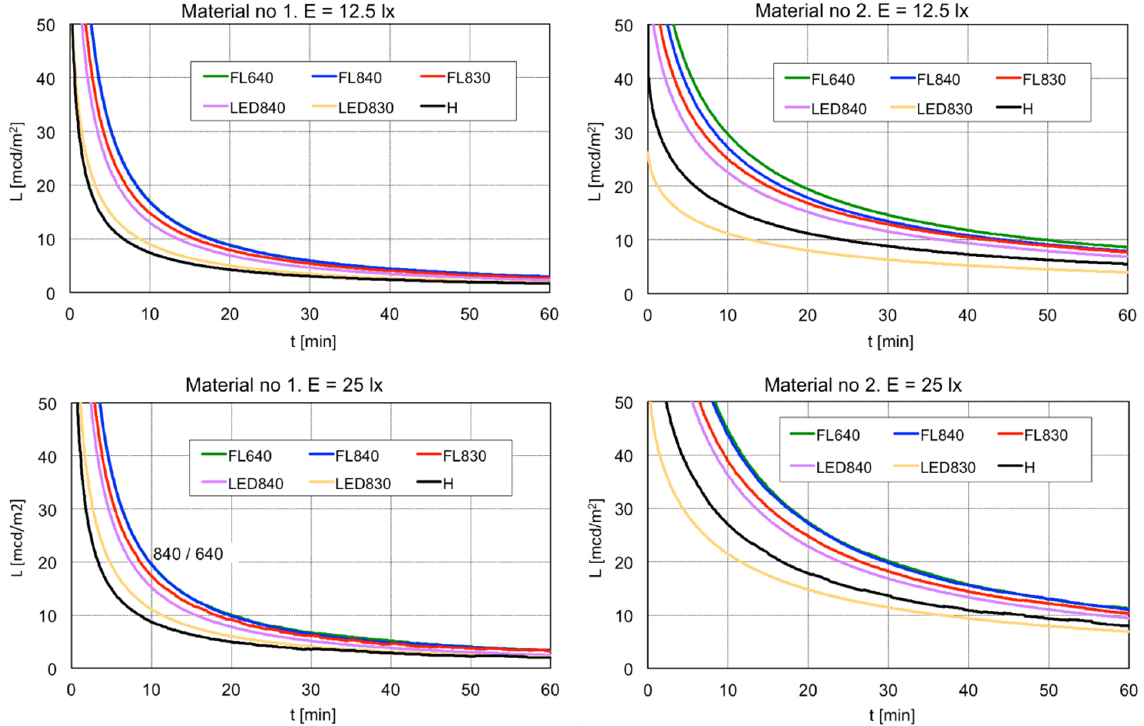
Figure 6. Luminance change in time after the disappearance of the excitation source for all tested lamps and two values of illuminance on the surfaces of the tested materials 12.5 lx and 25 lx.